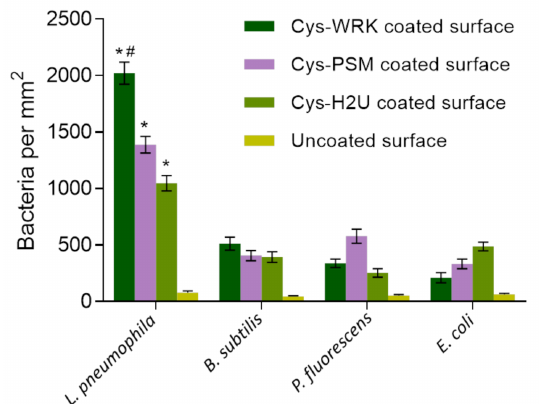
Figure 2. Bacterial-capture efficiency enumerated by optical microscopy following conjugation of different peptides with GaAs chips. Cysteine-modified warnericin AMP biosensor captured L. pneumophila 4 times more efficiently than the other investigated bacteria. Error bars represent standard error of the mean for five separate experiments. Statistical differences were measured by 2-way ANOVA followed by Tukey’s multiple comparison test with different bacteria and coatings as variables affecting capture efficiency. The asterisks (*) indicate significantly different values of L. pneumophila compared to reference bacteria ( p < 0.0001). The hash (#) indicates significantly different values for L. pneumophila on Cys-WRK compared to other coatings ( p <